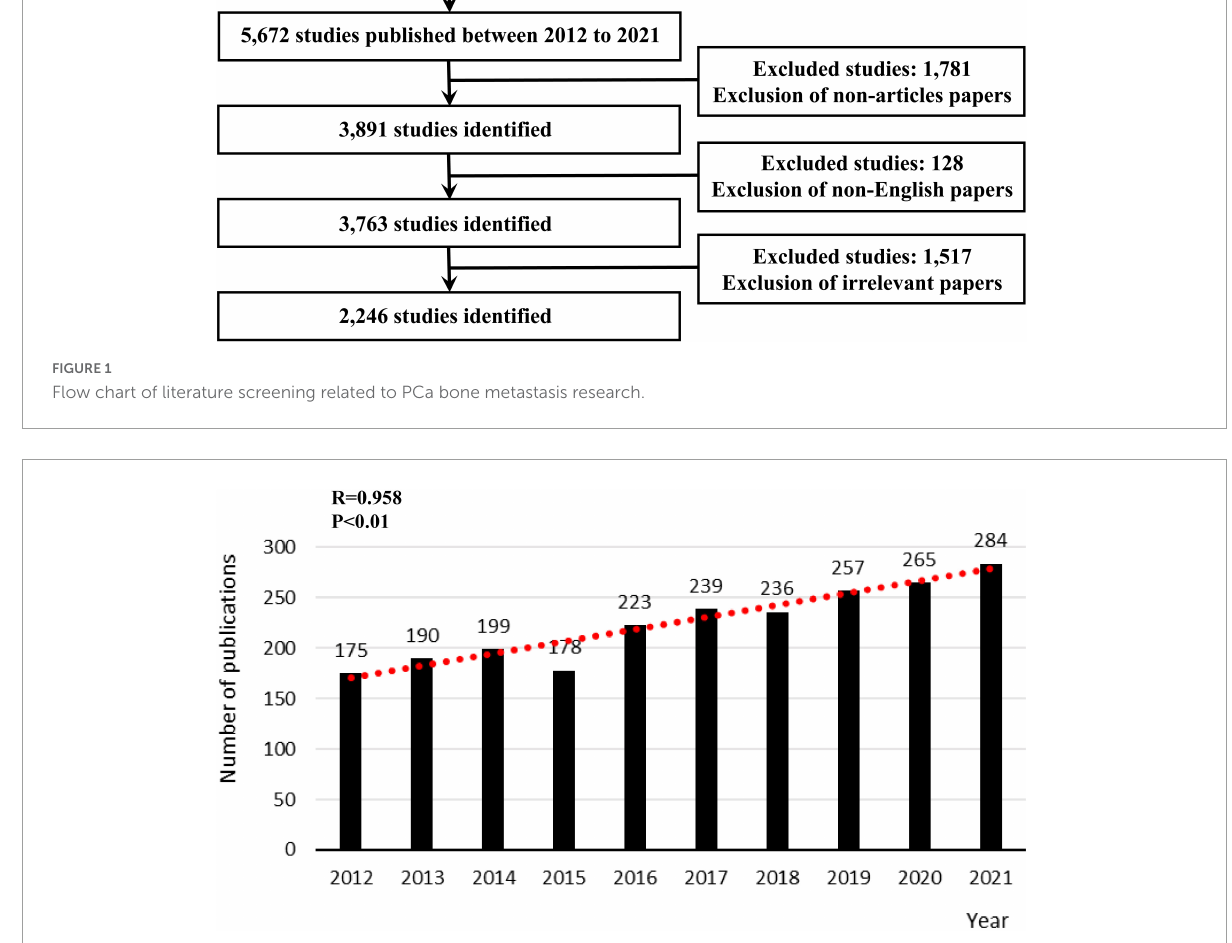
FIGURE2 The annual number of publications on PCa bone metastasis from 2012 to